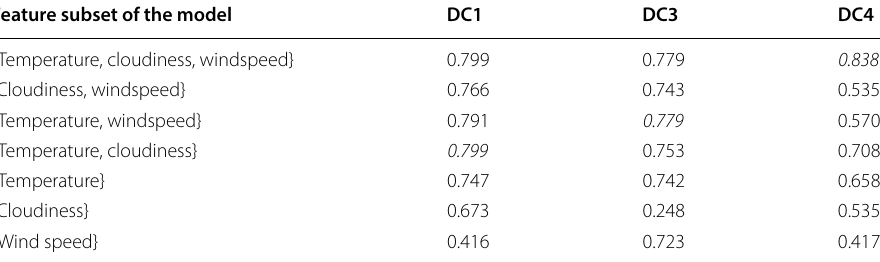
Feature ranking